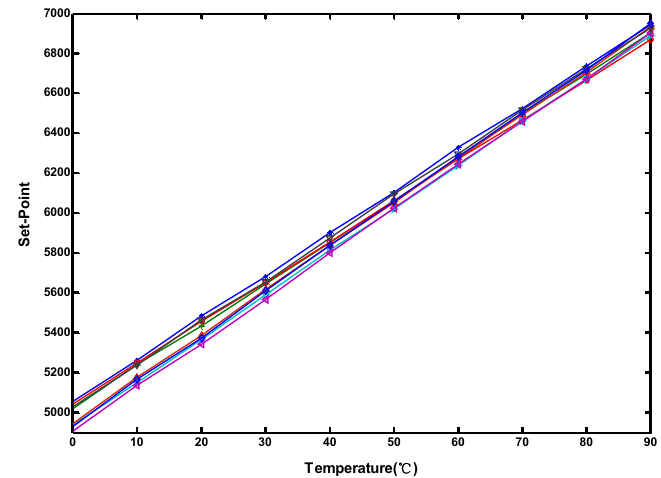
Figure 13. Trip temperature versus programmed set-point for eight test